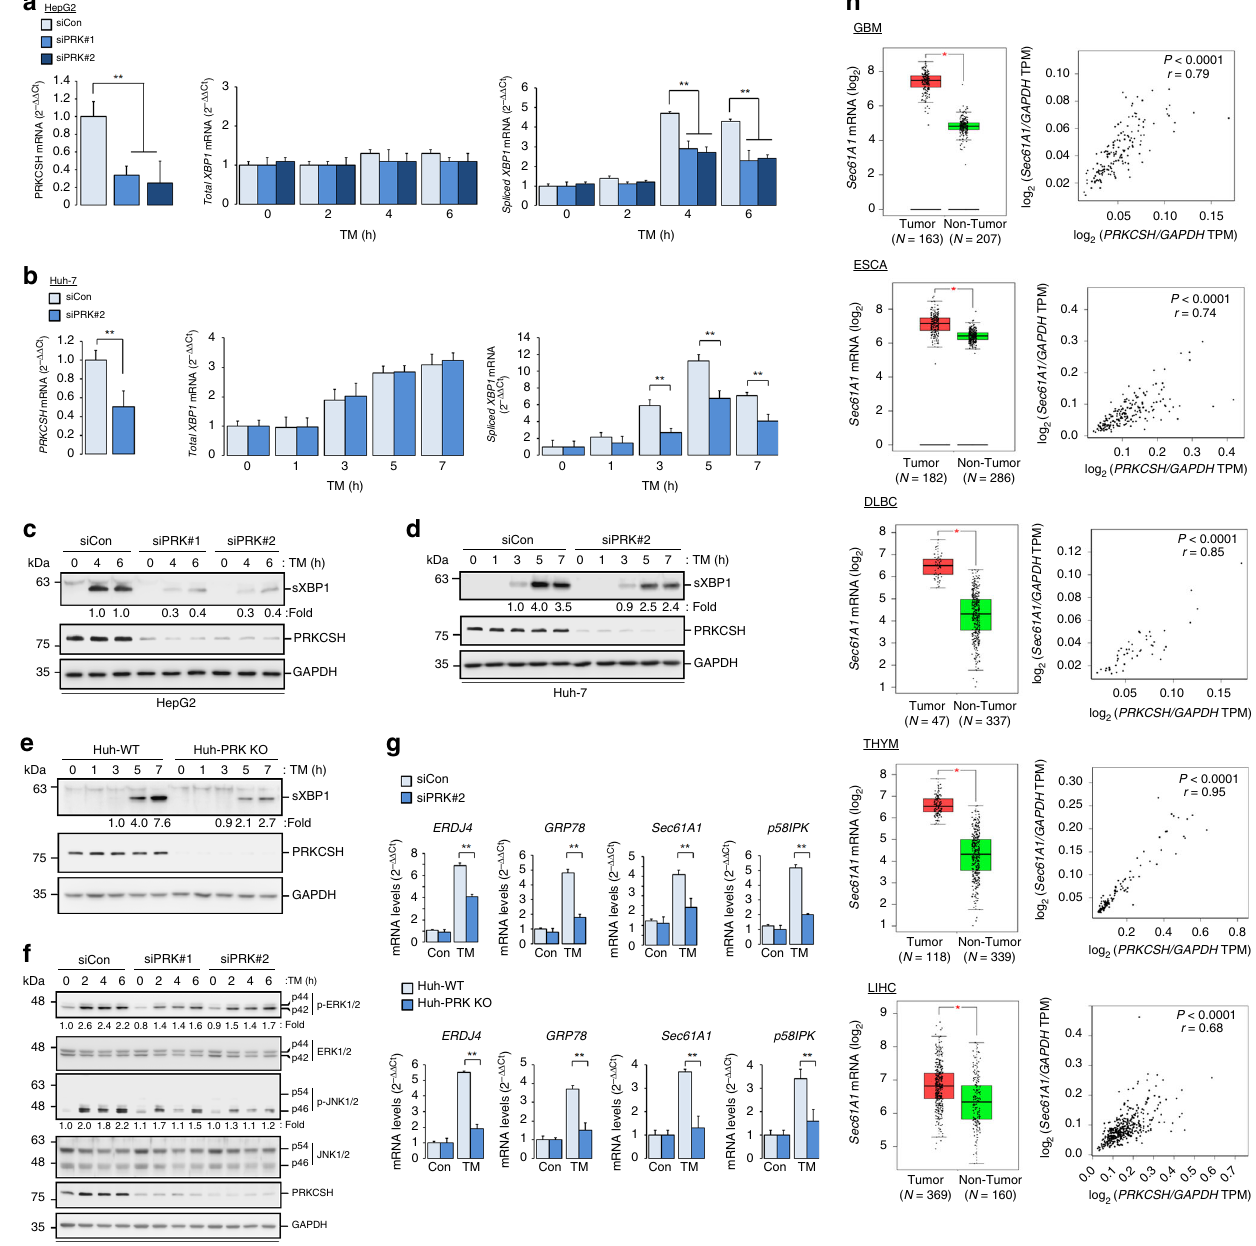
Fig. 3 PRKCSH is required for boosting activation of the IRE1 α pathway in hepatoma cells under ER stress. a , b Quantitative real-time PCR analysis of total XBP1 and spliced XBP1 expression in PRKCSH - silenced HepG2 ( a ) and Huh-7 ( b ) hepatoma cells treated with 10 μ g/mL TM for the indicated time. c , d Immunoblot analysis of sXBP1 protein levels in PRKCSH - silenced HepG2 ( c ) and Huh-7 ( d ) cells treated with 10 μ g/mL TM for the indicated time. e Immunoblot analysis of sXBP1 protein levels in Huh-WT and Huh-PRK KO cells treated with 10 μ g/mL TM for the indicated time. f Immunoblot analysis of ERK and JNK phosphorylation in PRKCSH - silenced HepG2 cells treated with 10 μ g/mL TM for the indicated time. g Quantitative real-time PCR analysis of UPR genes in PRKCSH - silenced Huh-7 cells or Huh-PRK KO cells treated with 10 μ g/mL TM for 5 h. sXBP1, phosphorylated ERK, and phosphorylated JNK levels shown below the blots were normalized to GAPDH, total ERKs, and total JNKs, respectively. For quantitative real-time PCR analysis, Data are represented as mean ± SEM from three independent experiments. One-way ANOVA; ** P < 0.01. h Expression of Sec61A1 as representative XBP1 target gene and its correlation with the levels of PRKCSH mRNA in glioblastoma multiforme (GBM), esophageal carcinoma (ESCA), lymphoid neoplasm diffuse large B- cell lymphoma (DLBC), thymoma (THYM), and liver hepatocellular carcinoma (LIHC) tissues. TCGA data were analyzed by using the GEPIA web tool. Scatter plots show relative expression of Sec61A1 mRNA in non-tumor and tumor tissues. The median expression levels in each group are indicated by horizontal lines. Signi fi cance of the differences between nontumor and tumor (left) was determined by one-way ANOVA ( P < 0.001). Correlation between Sec61A1 and PRKCSH (right) was determined by Pearson ’ s rank correlation coef fi cient. r Pearson correlation coef fi cient, P Pearson p